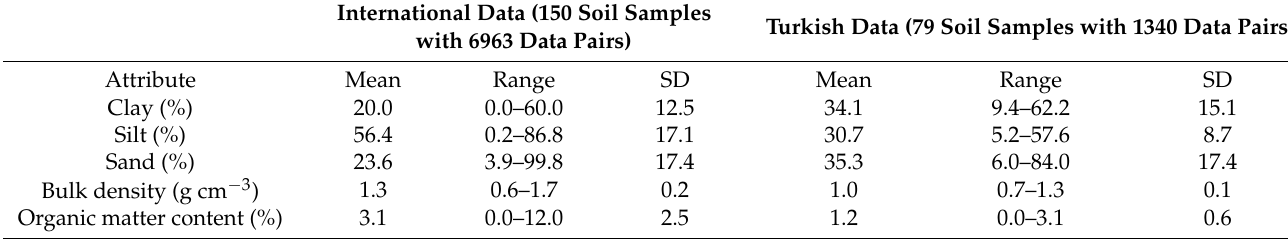
Figure 2. The soil hydraulic conductivity and tension pairs ( a ), and soil textural distribution for the datasets ( b ). Dark orange circles depict the international data set [20] and blue circles represent the Turkish dataset [21,28–30]. pF is the logarithmic transformation of soil tension in cm of water and K is the unsaturated hydraulic conductivity. Table 1. Characteristics of soils from international and Turkish data sets used in this study to develop and test pseudo continuous neural network pedotransfer functions (PC NN